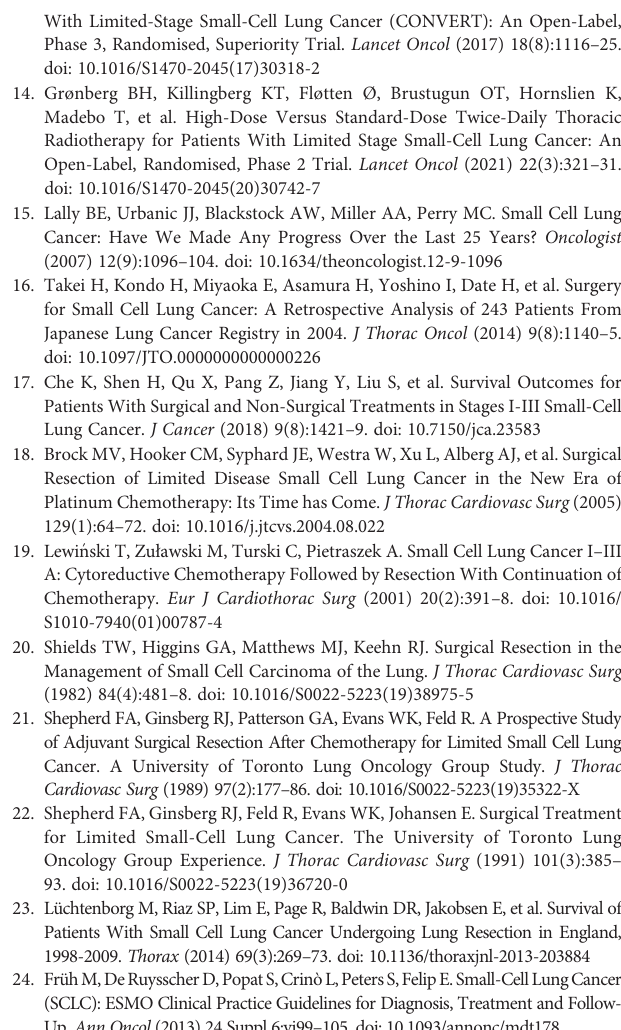
Supplementary Figure 5 | Survival analyses of overall survival (OS) for patients with AJCC stage III SCLC receiving chemotherapy-plus-surgery or surgery-alone treatment. (A) Kaplan-Meier analysis of OS before matching; (B) Kaplan-Meier analysis of OS after matching; (C) Kaplan-Meier analysis of OS after IPTW analysis; (D) Kaplan-Meier analysis of OS after Overlap Weighting